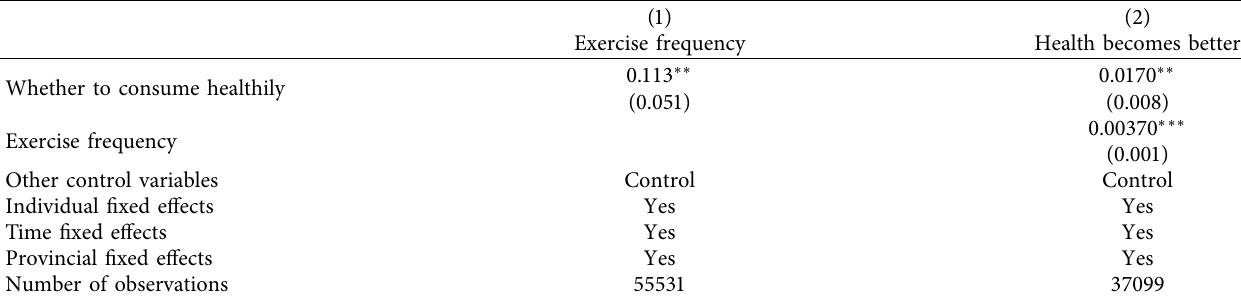
Table 8: Results of intermediate effect test.